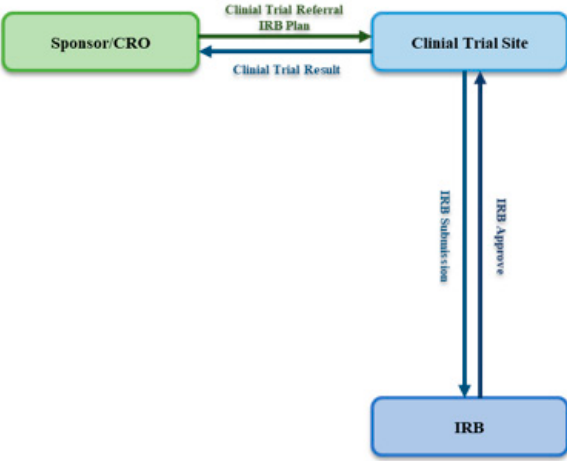
Figure 1. IRB approval process for the clinical trial on computer-based dementia assessment (Co-Wis).